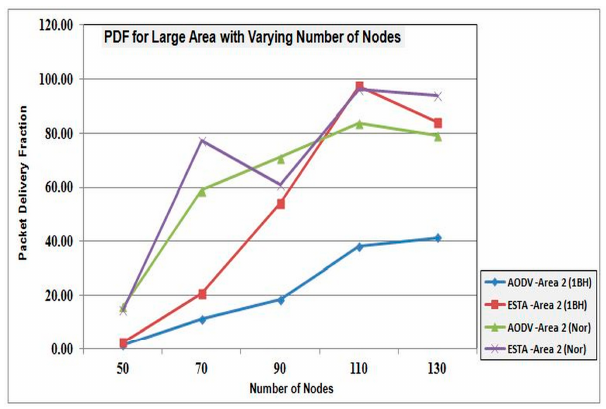
Figure 14. PDF for varying nodes in a large area.